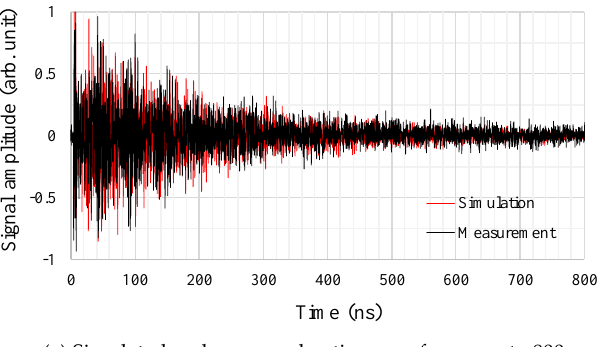
-1-0.500.5 Figure 8. Examples of the simulated and measured EM waveforms by sensor A. Figure 8. Examples of the simulated and measured EM waveforms by sensor Figure 9. Simulated and measured cumulative energies as a function of the UHF sensor positions. Figure 10. Cumulative energies as a function of time for the four UHF sensors. 4.2. Propagation Times of the EM Waves within a Transformer As the next step, the active parts of the transformer were installed into the tank. In order to validate the size and positions of the transformer winding model in the simulation, propagation times of the EM waves from the EM wave sources to each sensor were computed and compared with the experimental and theoretically calculated ones. In the experiment, the propagation times were obtained by simultaneous measurement of the exciting signal and the resultant EM wave signals, where arrival times of the EM waves were systematically calculated based on the Energy criterion method [8,21].